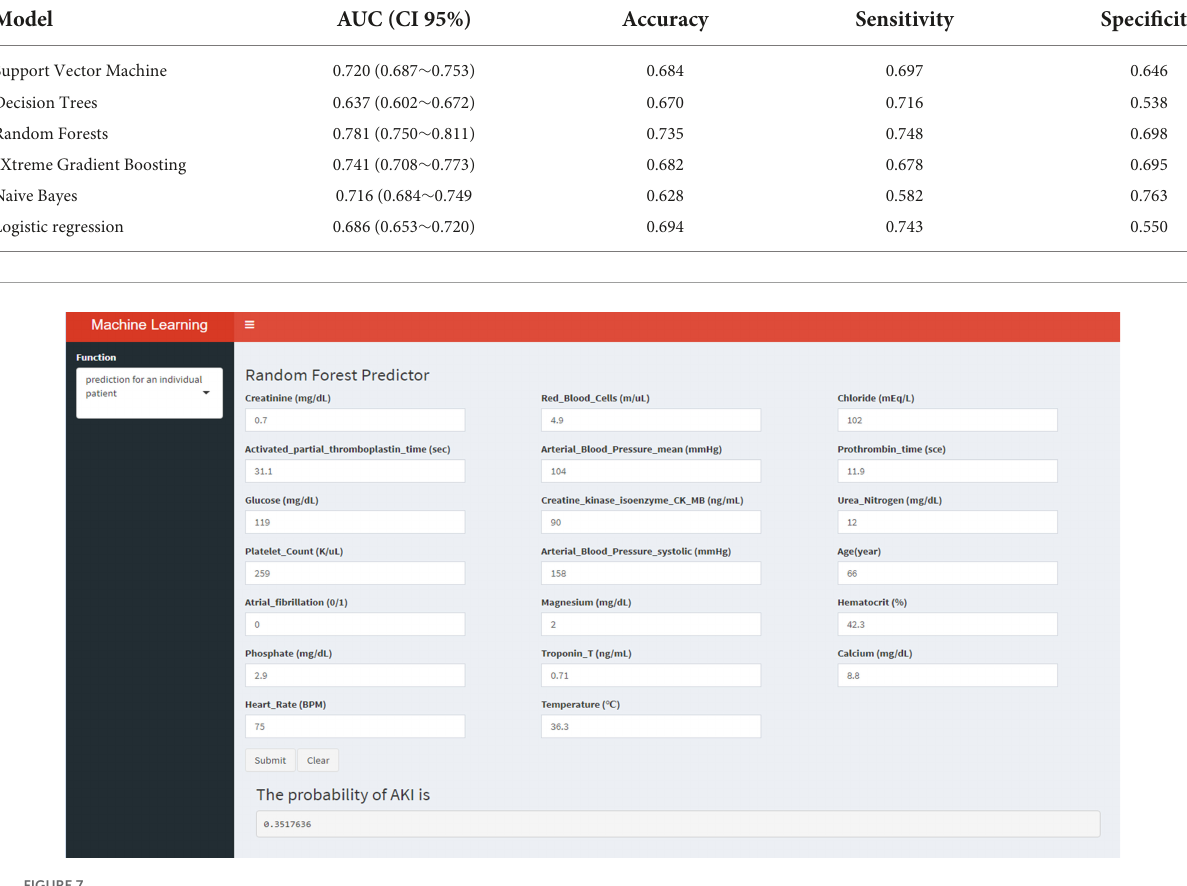
TABLE 2 The performance of six models containing the top 20 importance variables.